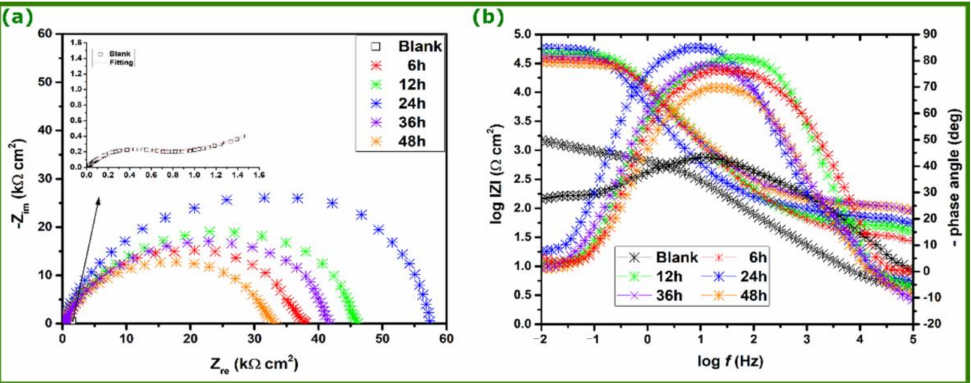
Figure 3. EIS data for copper in 3.5 wt.% NaCl with 150 ppm of ATZD at 298 K and different immersion times; ( a ) Nyquist and ( b ) Bode